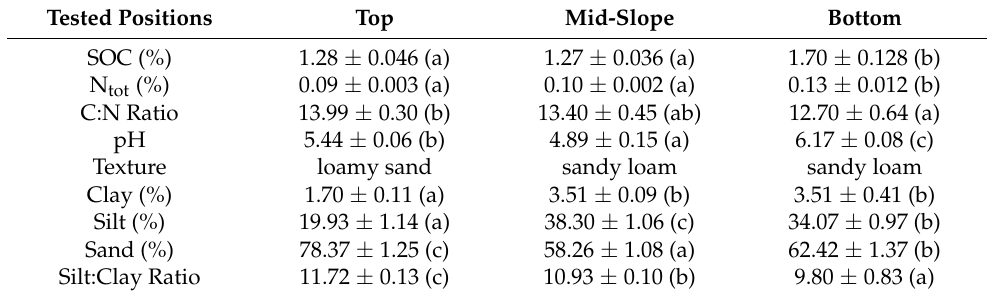
Table 1. Physicochemical parameters of soils collected along the topographical gradient of the forest gully: top, mid-slope, and bottom (average values ± sd; n = 3; the same letter indicates no significant difference; ANOVA, Tukey HSD test, p <